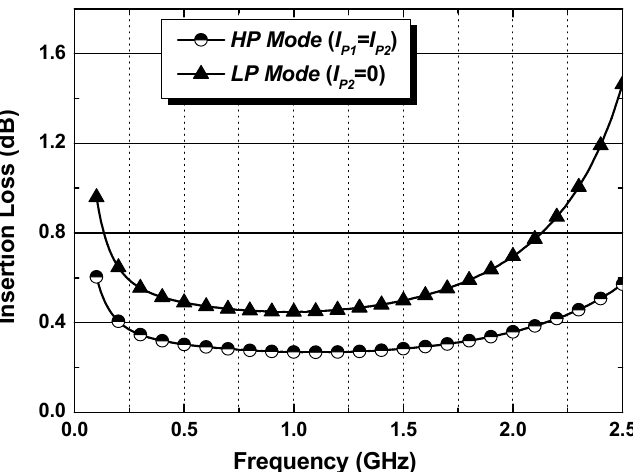
Figure 5. EM simulated insertion loss in HP and LP modes for the PCT.